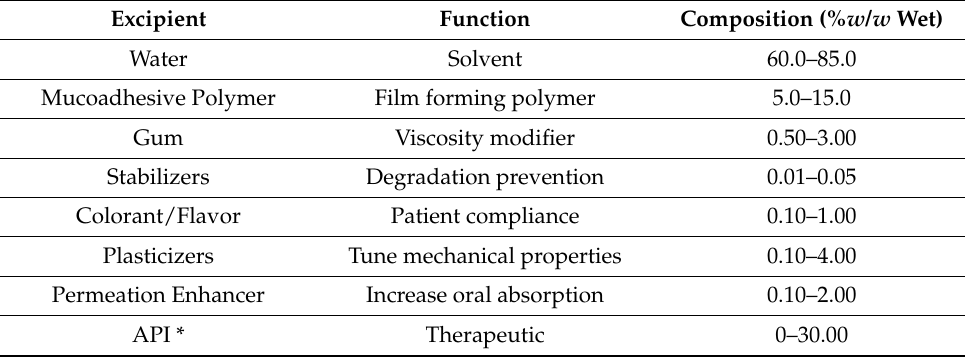
Table 1. General composition of the mucoadhesive